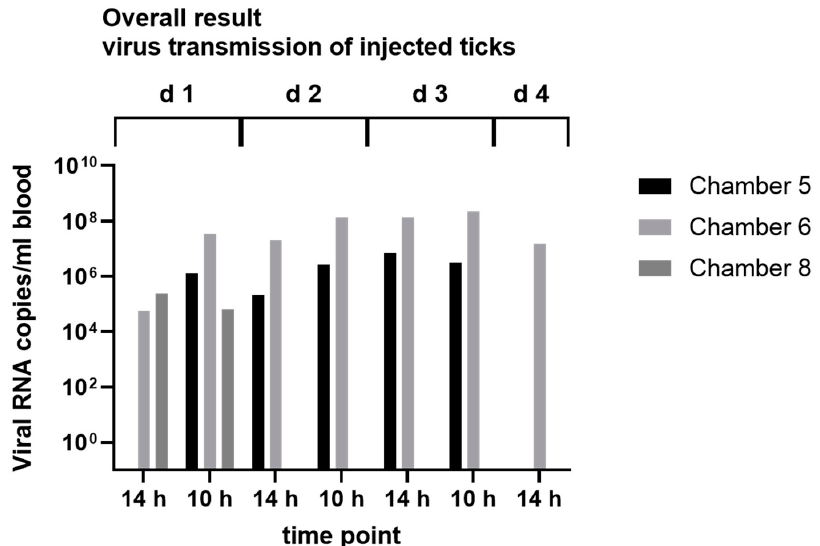
Figure 2. Results of virus transmission experiments with ALSV-injected ticks. ALSV RNA cop- ies/mL blood were measured on 7 different time points (1–7) after 10 h (sampling in the afternoon) or 14 h (sampling in the morning) of incubation of ALSV-injected ticks in feeding chambers 5, 6 and 8. Feeding experiments lasted 3½